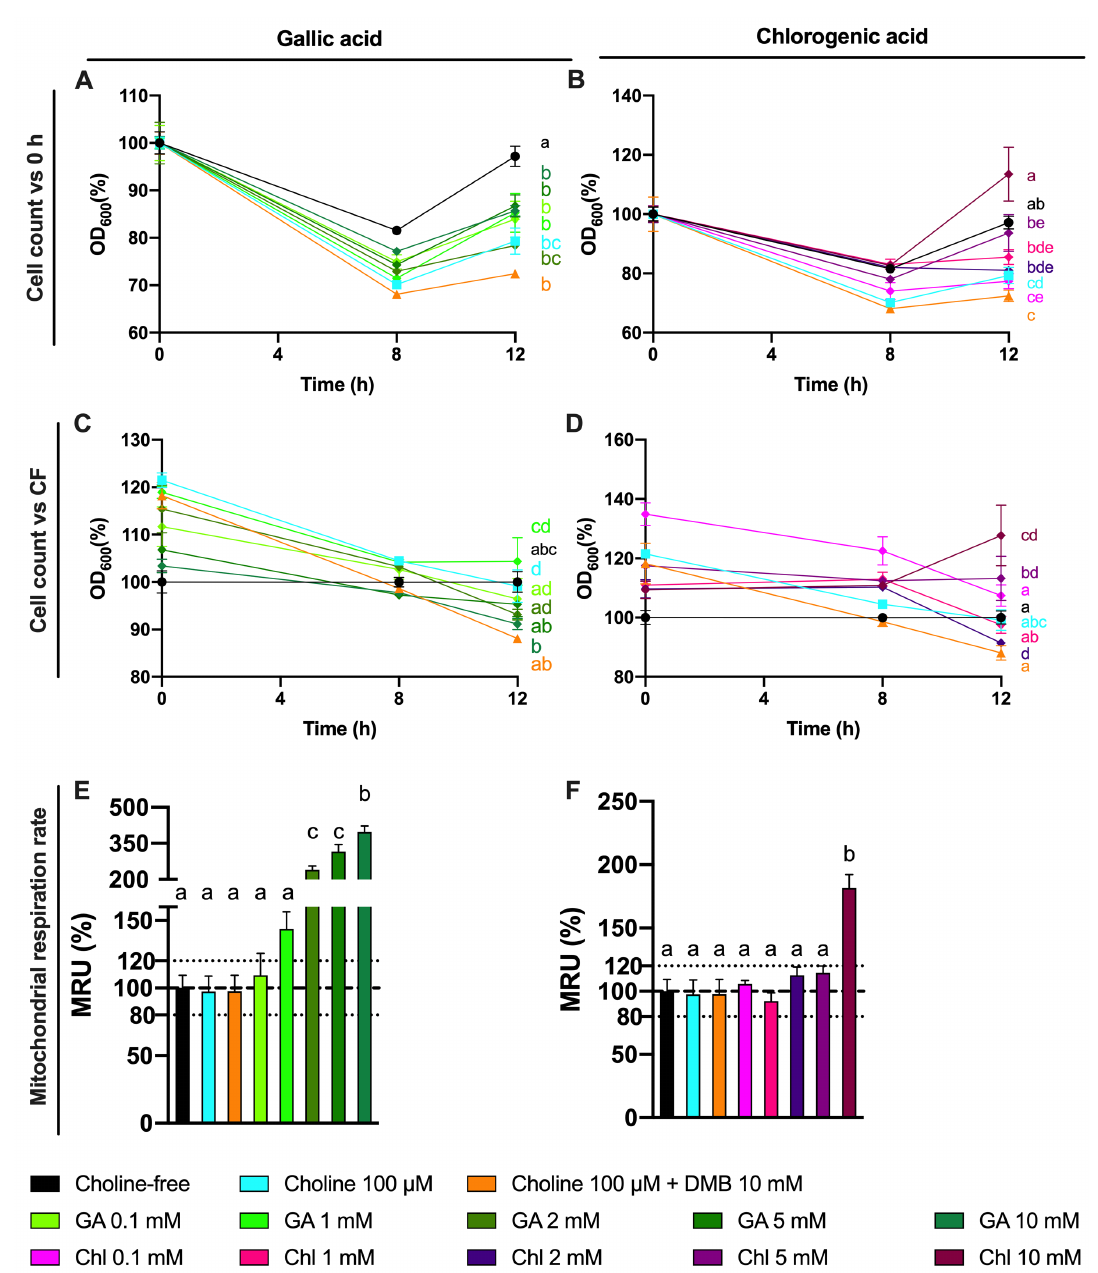
Figure 11. Effect of gallic acid and chlorogenic acid (0.1–10 mM) on approximate cell count (optical density at 600 nm) over time relativized to initial (0 h) absorbance values ( A , B ). Effect of gallic acid and chlorogenic acid (0.1–10 mM) on approximate cell count (optical density at 600 nm) relativized to choline-free (0 µ M) conditions at the end (12 h) of the fermentation ( C , D ). Effect of gallic acid and chlorogenic acid (0.1–10 mM) on mitochondrial respiration rate relativized to choline-free (0 µ M) conditions at the end (12 h) of the fermentation ( E , F ). All fermentations were carried out at optimal conditions (fecal slurry 20% and choline 100 µ M). Results are expressed as mean (%) ± SEM ( n = 6). Different letters indicate statistical differences ( p < 0.05) by one-way or two-way ANOVA (Tukey’s post hoc test). Factors for two-way ANOVA were gallic acid or chlorogenic acid concentration and time. Abbreviations: DMB, 3,3-dimethyl-1-butanol; GA, gallic acid; and Chl, chlorogenic